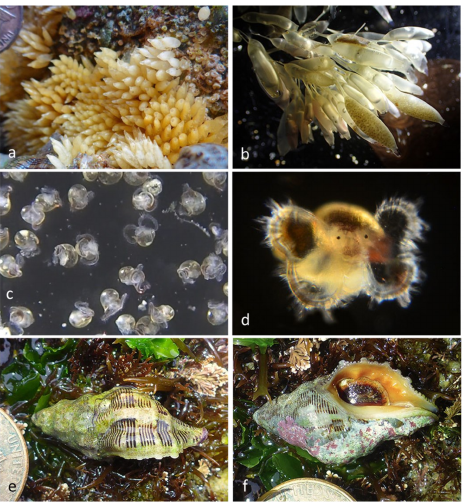
Figure 14. Family Nassariidae. Western mud nassa , Nassarius tiarula. (BIN ACV0694; n = 1 veliger, 7 adults). ( a ) Veliger BIOUG01205-G06 from Via Lido and Genoa, Lido Island. ( b ) Adult CCDB32329 G01 from Balboa at Coral (mud grab). ( c ) Adult CCDB-32329 F07 from Crew Dock, Back Bay Science Center (mud grab). ( d ) Adult CCDB-32329 F06 from Crew Dock, Back Bay Science (mud grab).